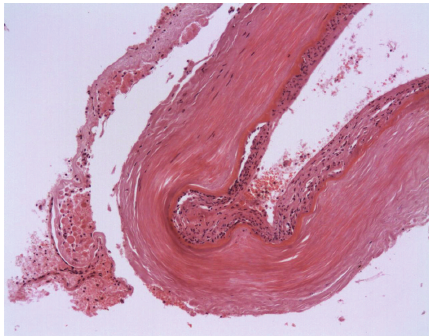
Figure 1: Infiltration of the adventitia and vasa vasorum of the basilar artery by signet ring adenocarcinoma cells.